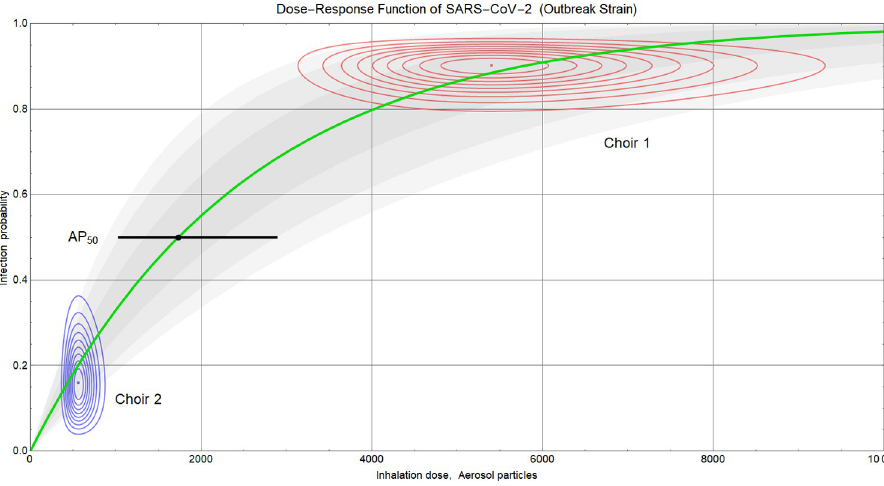
Fig 10. Dose-response relation Eq (8), A.6 in S1 Appendix, for different values of the quantum γ . Green curve: Median, γ = 2497 aerosol particles. Gray shaded areas: Central credibility regions for 68.3%, 95%, and 99% coverage. Black marker: Median (1731) and 95% CI (1039 ─ 2883) of the particle dose leading to infection with 50% probability (AP 50 ). Red and blue contours: Linear equidistant iso-lines of the probability density of pairs (Z, p LR ) as inferred from the two choir